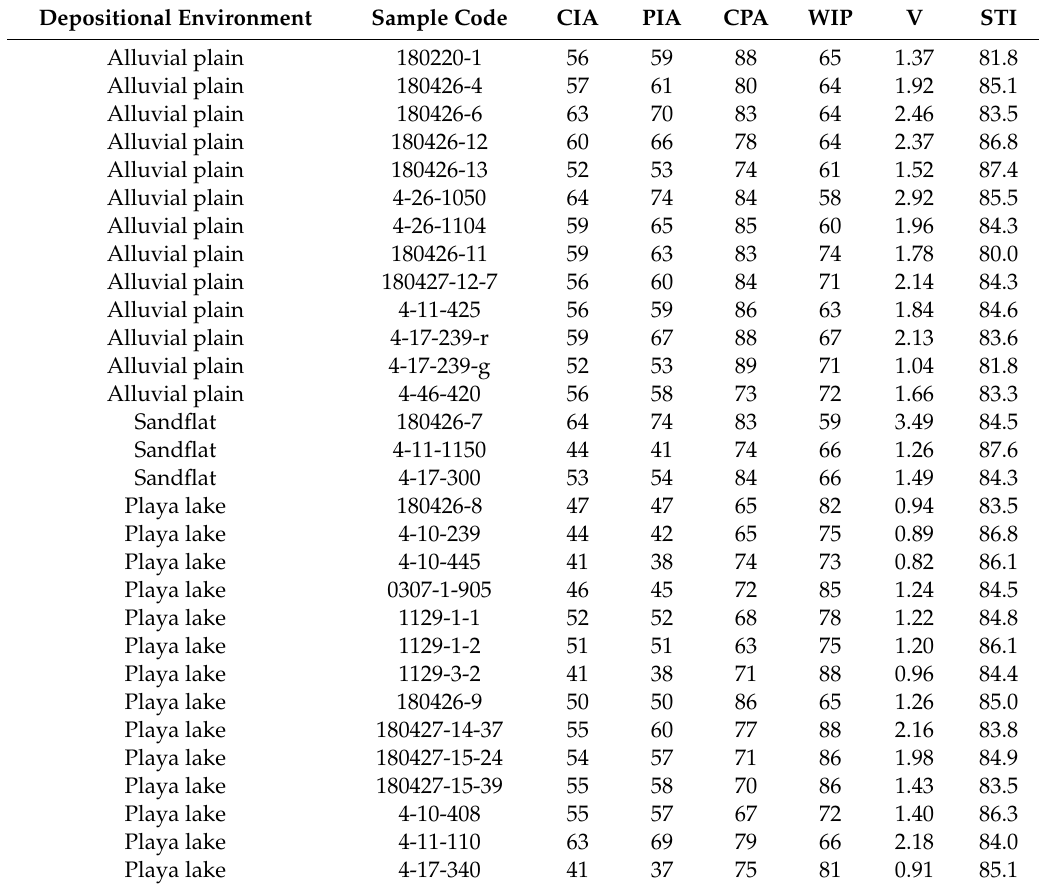
Table 1. Weathering indices for the mudstone samples from the Neungju